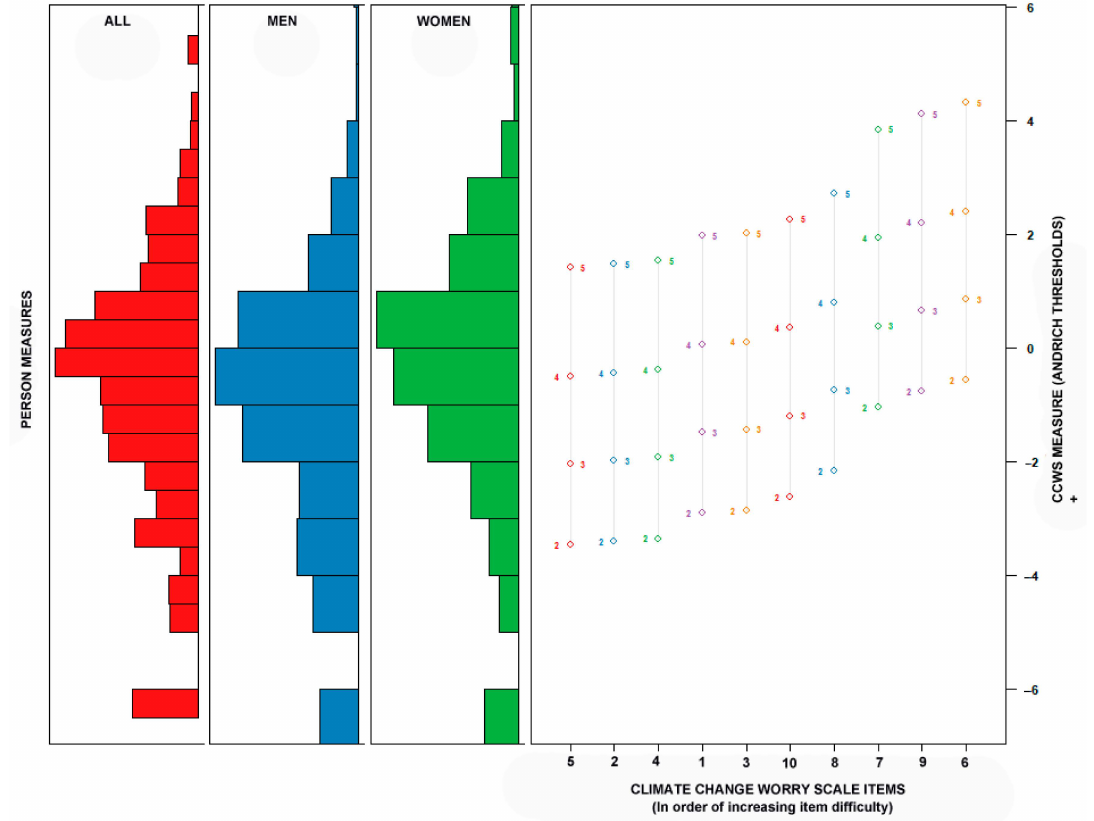
Figure 2. Wright map of the Climate Change Worry Scale